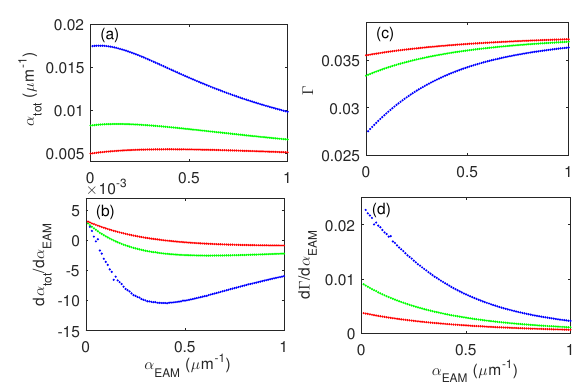
Figure 3. (color online) Dependence of ( a ) total absorption α tot of the EAM-VCSEL, ( b ) its derivative d α tot / d α EAM , ( c ) VCSEL cavity confinement factor Γ and ( d ) its derivative d Γ / d α EAM on the EAM absorption α EAM . Color coding for the three representative cases of different coupling strength between the EAM and VCSEL cavities are the same as for Figure